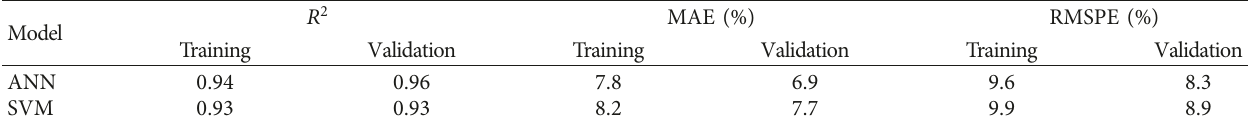
Figure 11: Measured versus predicted IRI t using the SVM model: validation Table 2: Comparison between roughness prediction models.